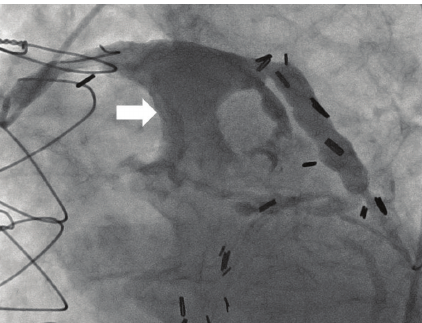
Figure 2: Saphenous venous graft angiography showing giant aneu- rysm (arrow) with organized